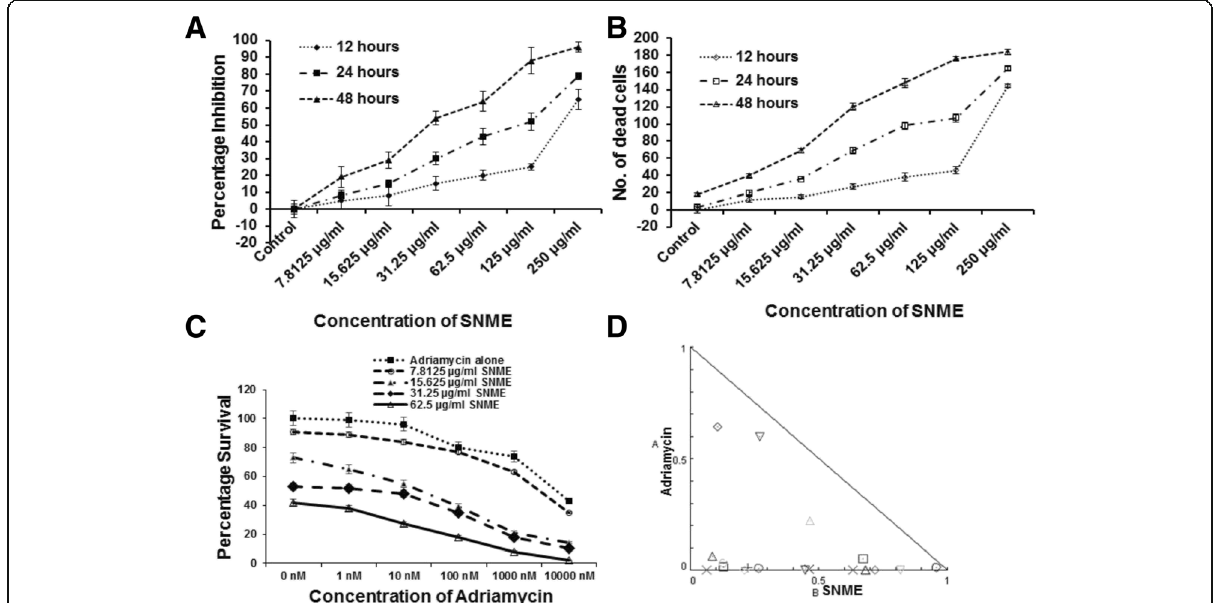
Fig. 2 a , Effects of SNME on NCI/ADR-RES cell proliferation. Cells were treated with 7.8125, 15.625, 31.25, 62.5, 125 and 250 μ g/ml of methanolic extract for 12, 24 and 48 h. Control cells were maintained in the vehicle for the indicated time periods. The percentage inhibition increases as the concentration of SNME increases and the IC 50 value obtained was 125 μ g/ml at 24 h. Results are represented as mean ± SEM of three assays. b , Effects of SNME on NCI/ADR-RES cell viability. Cells were treated with 7.8125, 15.625, 31.25, 62.5, 125 and 250 μ g/ml of methanolic extract for 12, 24 and 48 h. Control cells were maintained in the vehicle for the indicated time periods. Results are represented as mean ± SEM of three assays. c , Effects of Adriamycin and Adriamycin – SNME combination treatment on NCI/ADR-RES cell proliferation. Cells were treated with